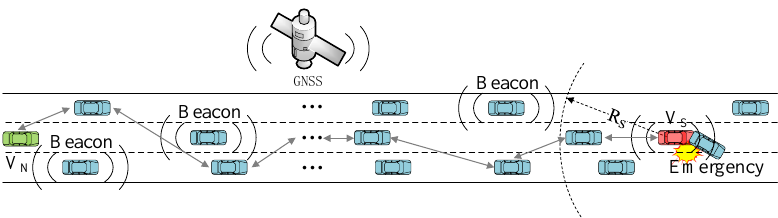
Figure 1. Transmission of beacon and emergency messages in highway scenarios.